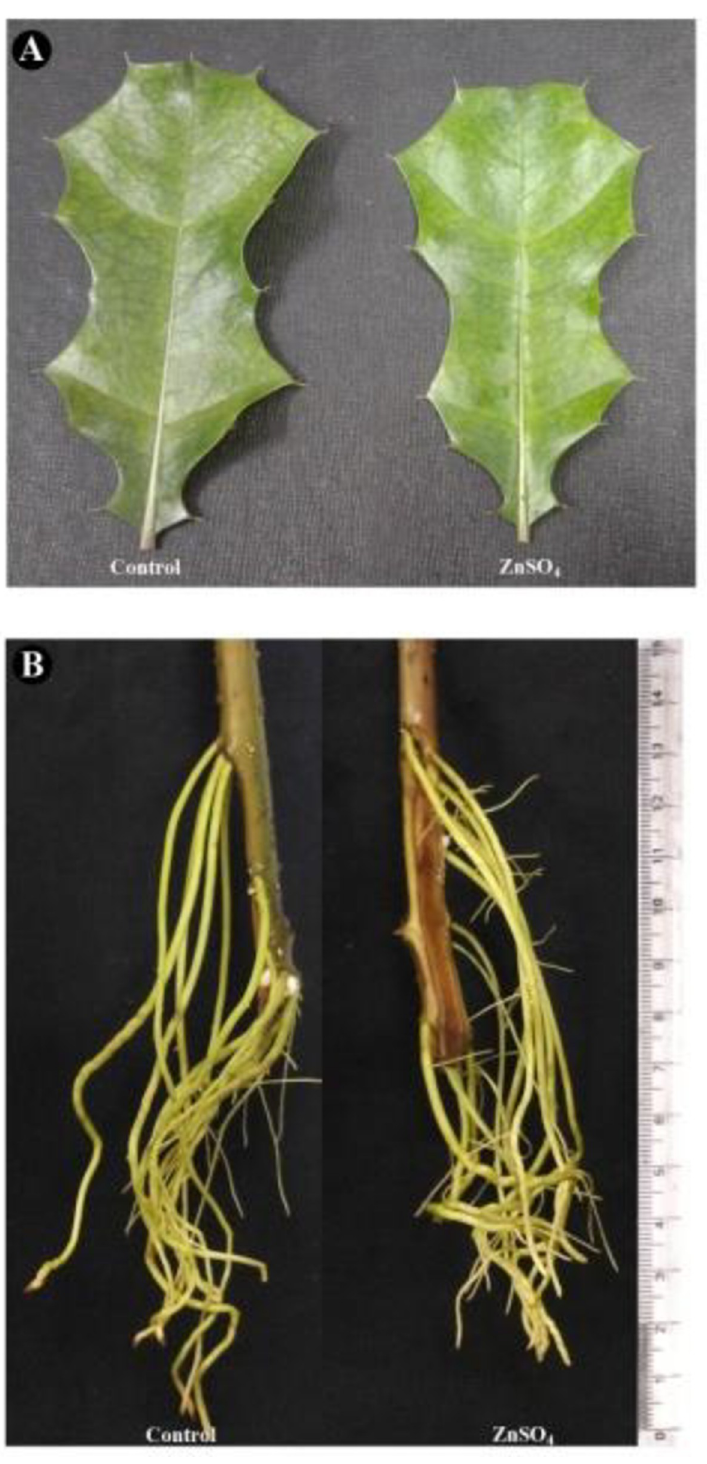
Fig 1. Leaf area (A) and root length (B) of A . ilicifolius L. (control and ZnSO 4 treated).